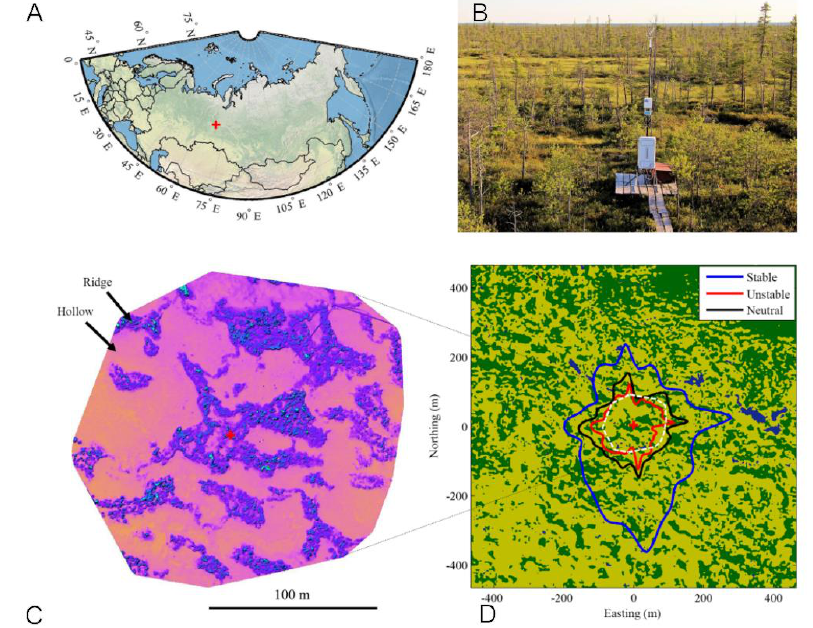
Figure A2. ( A ): Map showing the Mukhrino station location. ( B ): photo of the EC tower facing southwest. ( C ): Digital elevation map based on drone survey. ( D ): Surface-type classification map. ( D ) includes an eddy covariance footprint overlay, with the isolines giving the 70% cumulative EC source zone in the three stability classes. Colour coding in ( D ) is as follows: dark green = ridges-hummocks, light green = lawns-hollows, dark blue = ponds. The red cross marks the location of the EC tower. Adapted from [26]. Table A1. List of sensors, parameters and installation site at Mukhrino field station, 2010–2019. n Parameter Equipment